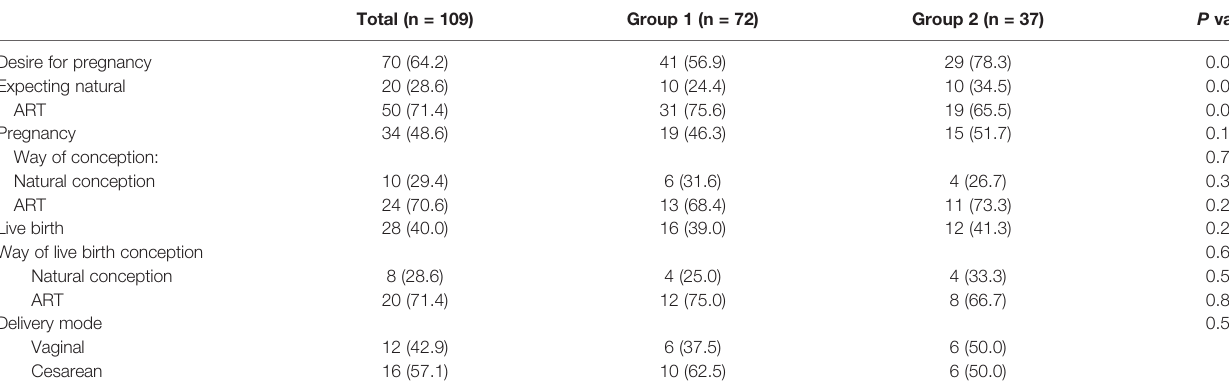
TABLE 5 | Pregnancy outcomes of patients with different treatment after achieving complete response (%).